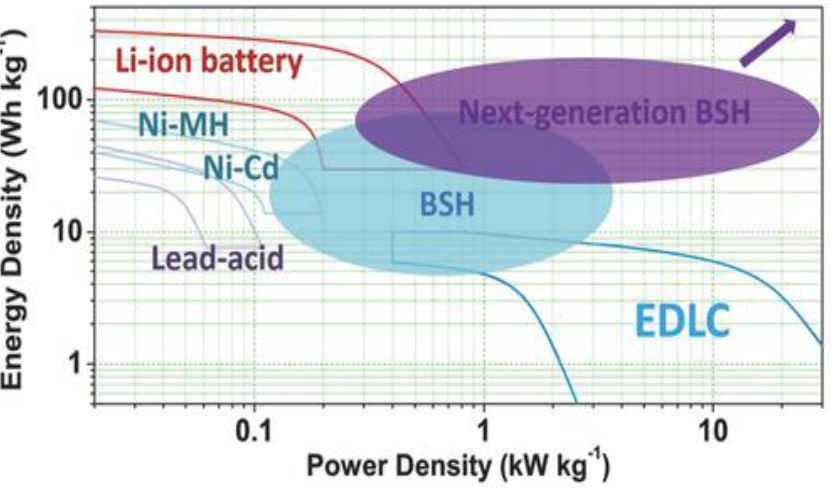
Figure 9. Ragone plots of various rechargeable batteries and EDLC, and the comparison with BSHs. Reprinted with permission from [110]. Copyright 2017 Willey online library .